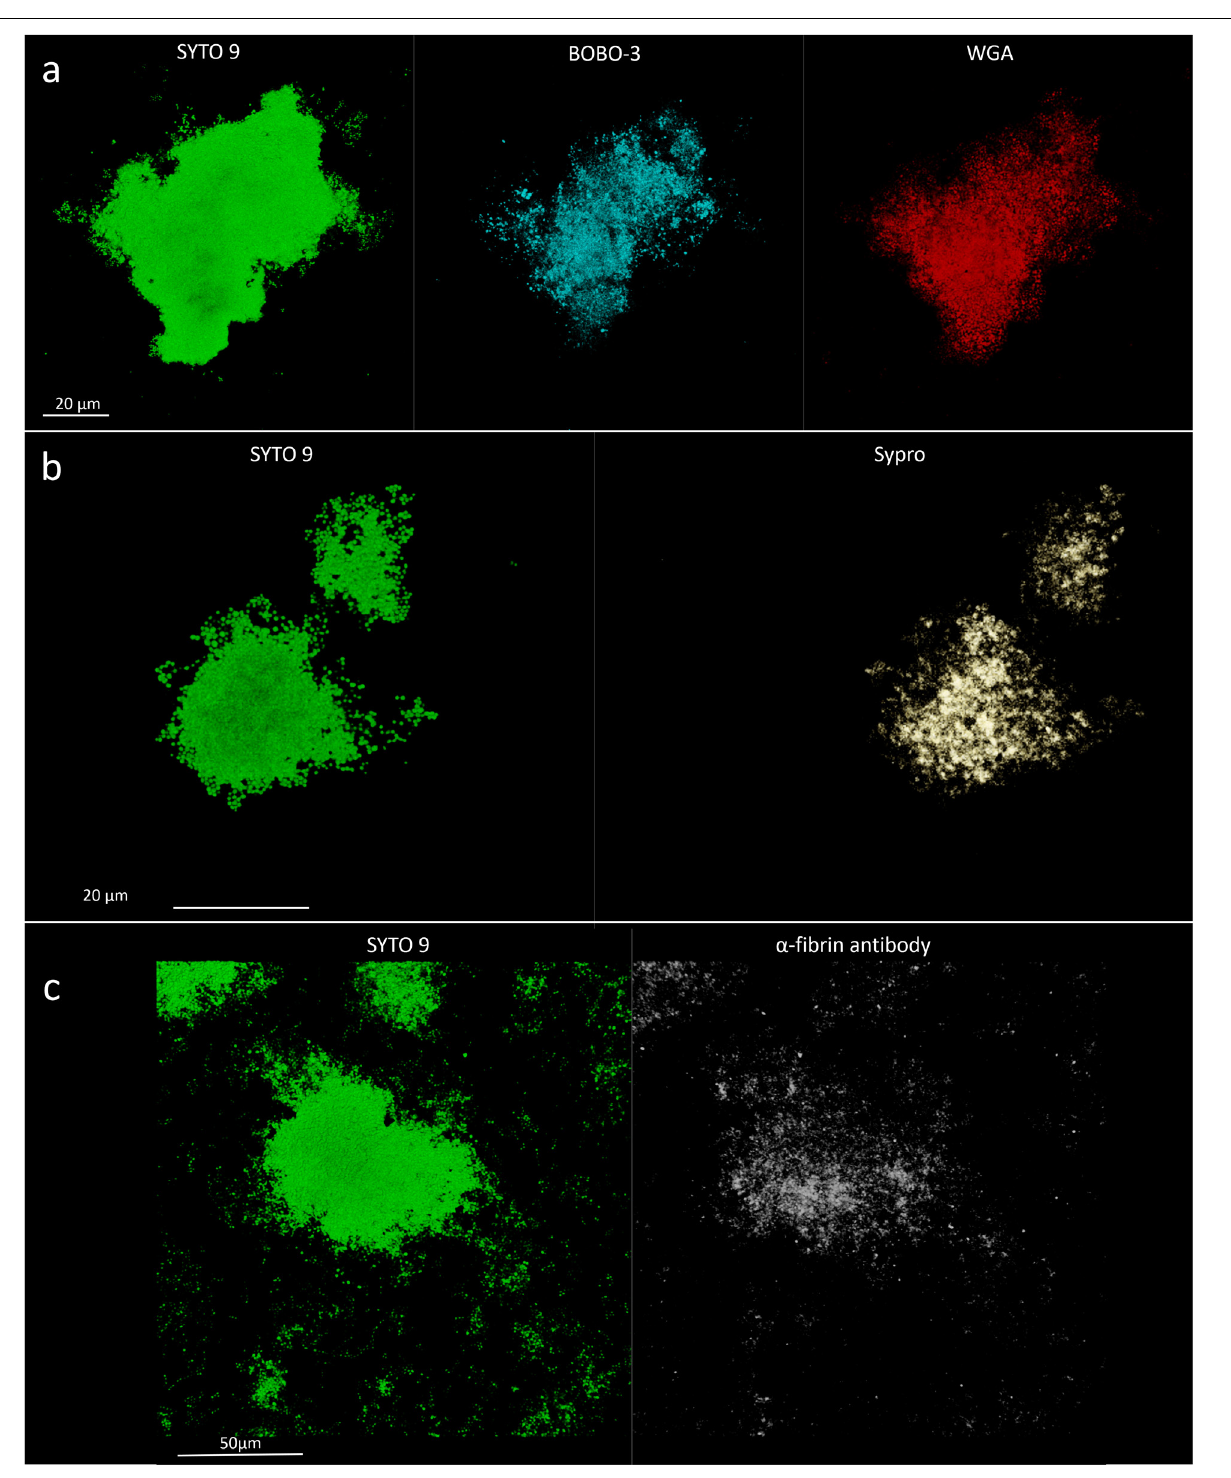
Frontiers in Microbiology |